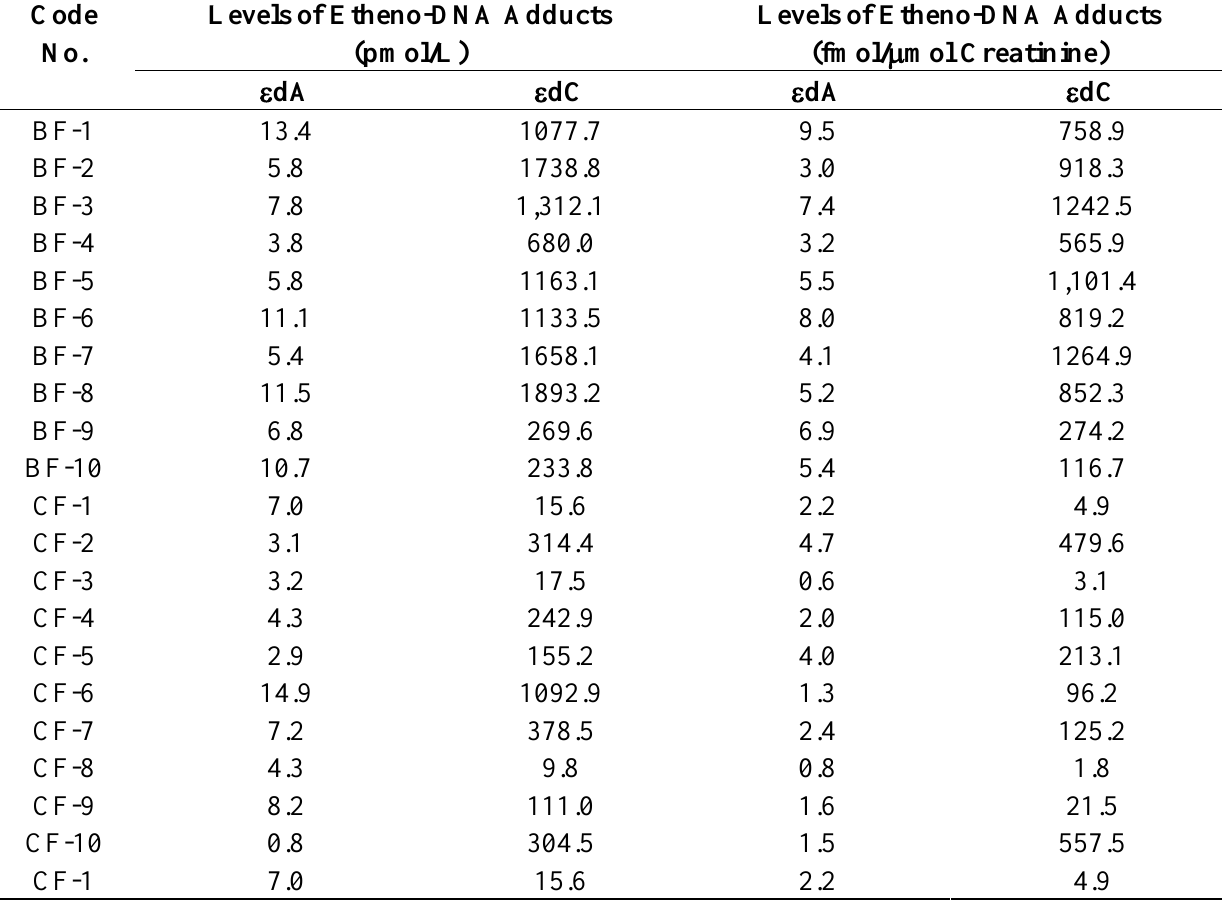
Table 2. Levels of etheno-DNA adducts detected in human urine